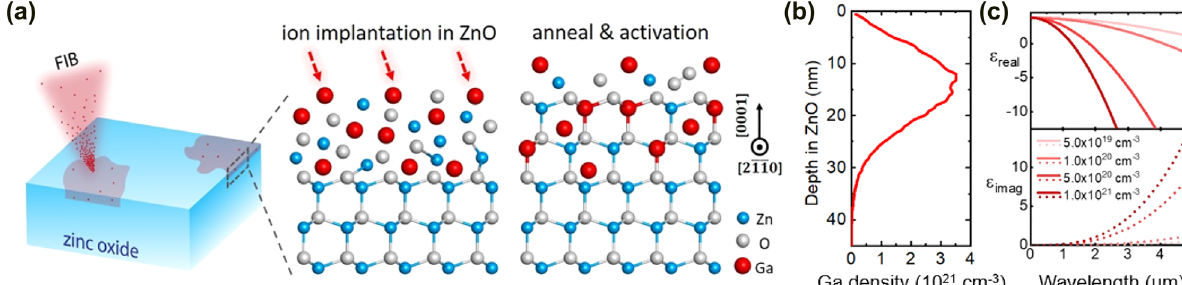
Figure 1: Mechanisms of tuning carrier density in ZnO using a focused ion beam (FIB). (a) Schematic of FIB-assisted doping process: The surface of a single-crystalline ZnO substrate can be doped using FIB implantation and subsequent high-temperature annealing. (b) Depth profile of 30-keV Ga ions impinging into crystalline ZnO, simulated using TRIM. (c) Calculated real and imaginary parts of the complex permittivity of Ga-doped ZnO with varying carrier